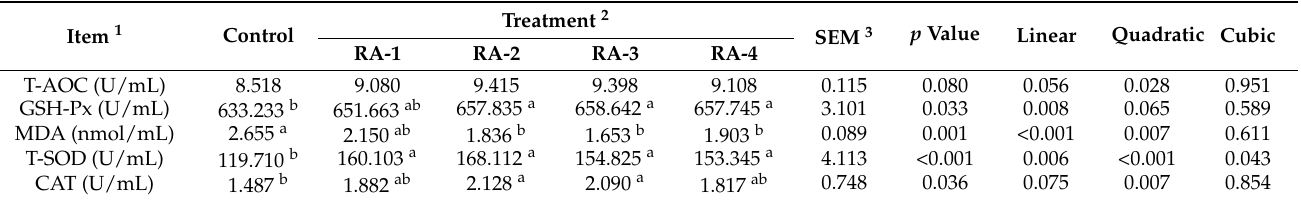
Table 5. The effect of dietary supplementation with rosmarinic acid (RA) on serum antioxidant activity of